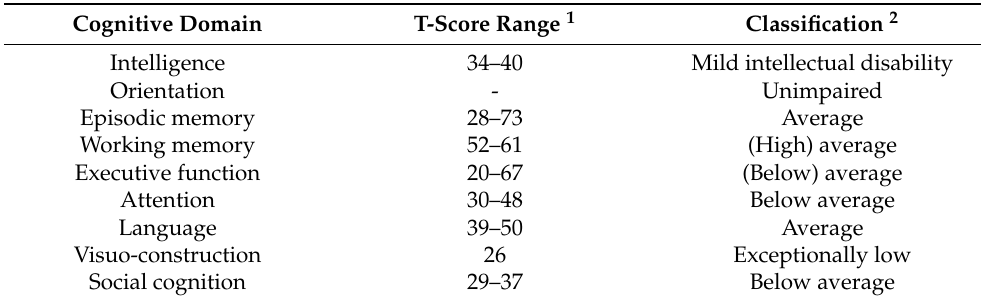
Table 1. Overview of the patient’s performance on neuropsychological assessments per cognitive domain (standard scores and